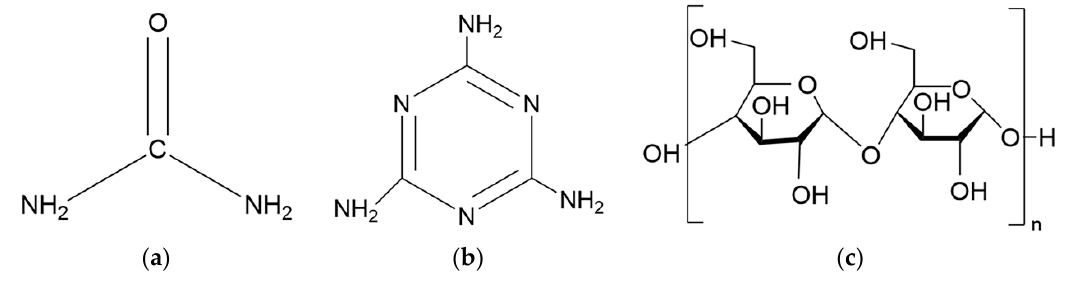
Figure 3. The molecular structures of urea ( a ), melamine ( b ), and starch ( c ). Table 2. Results of each adulterant in the prediction set based on the corresponding best